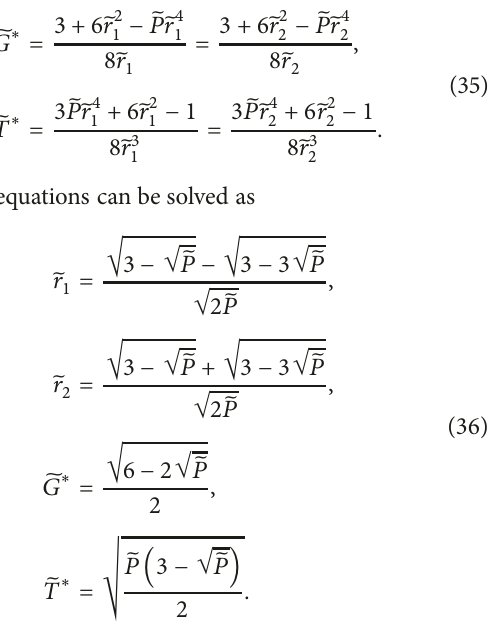
Figure 5: Left panel shows the cross point is the phase transition point. Right panel shows system’s swallow tail behavior, and the cross point is the phase transition